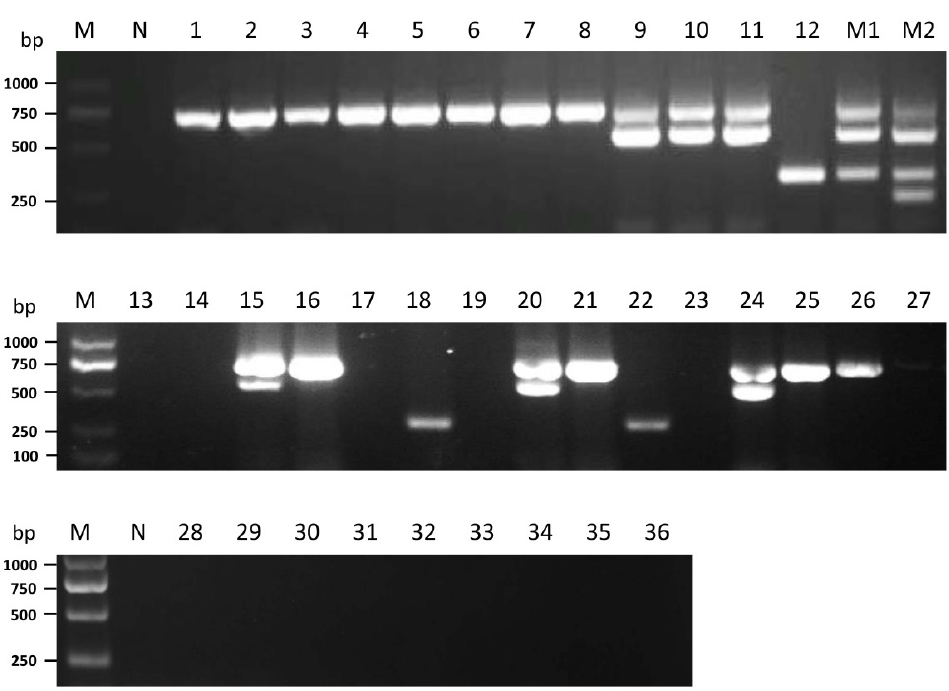
Figure 4. Viruses’ detection of P. ostreatus strains using the developed multiplex RT-PCR. Numbers 1–36 represent the 36 strains in Table 2. Lane M1 represents the mixed strains of PG-ZP20 and TD300. Lane M2, combined strains of PG-ZP20 and TD300 with the plasmid pTPoV1. N, negative control, the healthy P. ostreatus sample. Lane M: GL DNA Marker2000.